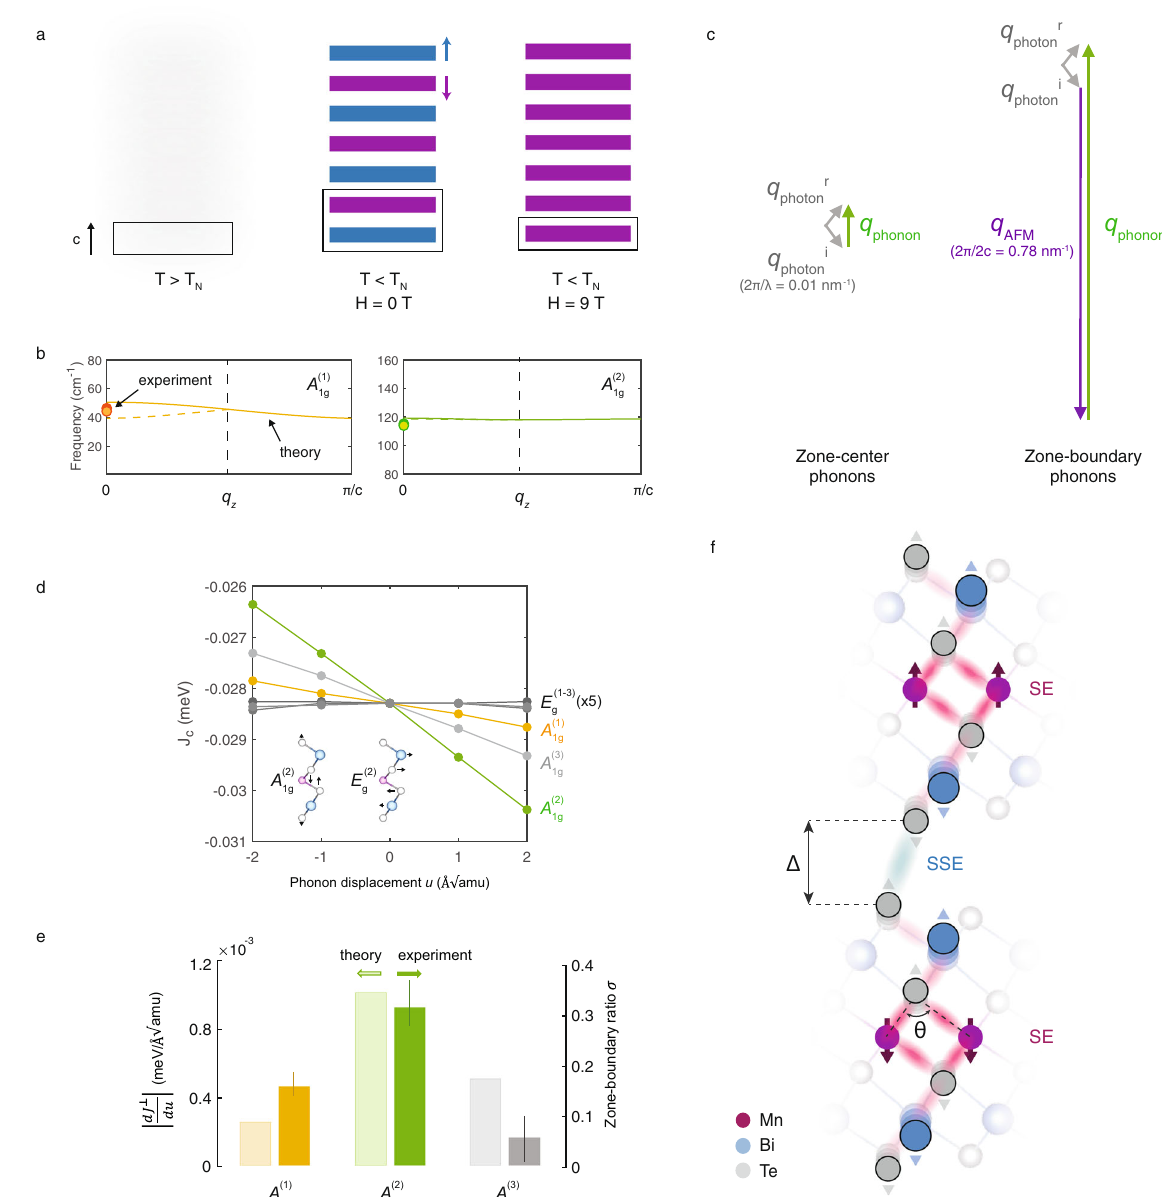
Fig. 3 Magnetophononic wave-mixing. a Schematic of layered magnetic ordering in MnBi 2 Te 4 , with blue and purple denoting opposite in-plane spin orientations, and gray denoting disordered spins. The antiferromagnetic (AFM) wavevector is shown schematically, labeled “ q AFM ” . b The dispersion relations of the A 1 g (1) and A 1 g (2) modes along the c-axis, calculated using density functional theory. The experimental zone-center and zone-boundary phonon frequencies are denoted using colored and empty circles respectively. c Schematic of wave-mixing for zone-center and zone-boundary modes. The wavevectors of the photon (i = incident, r = re fl ected), phonon, and AFM spin-wave are shown using gray, green, and purple arrows (not drawn to scale). (cid:6) (cid:6) d Modulation of the interlayer exchange coupling J ? by Raman phonons. Inset shows the eigendisplacements of two representative phonons. e Comparison (cid:6) (cid:6) (cid:6) (cid:6) and the experimental zone-boundary ratio σ (see text for de fi nition). Error bars are between the calculated magnetophononic scattering cross-section dJ ? du standard deviations in fi t values. f Schematic of superexchange (SE) and super-superexchange (SSE), with Δ denoting the interlayer distance, θ denoting the Mn – Te – Mn bond angle, and pink and blue clouds denoting SE and SSE pathways, re fl ectivity is sensitive to changes in carrier density and coherent Finally, we investigate magnetophononic coupling by direct phonons. These measurements are carried out at 2 K, as a func- measurement of phonons in the time domain. To do this, we carry tion of magnetic fi eld from 0 to 6.4 T, across the spin- fl op tran- out “ pump-probe ” experiments to generate and detect coherent sition. The transient re fl ectivity, shown in Fig. 4b, exhibits an optical phonons as a function of magnetic fi eld (see schematic in initial sub-picosecond dip, followed by a slow relaxation. Over- Fig. 4a). Excitation with ultrafast optical pump pulses (1.55 eV, layed on this are multiple distinct coherent oscillation compo- 50 fs) results in the generation of coherent phonon oscillations. A nents that (as described below), correspond to the A 1 g (1) and A 1 g (2) phonons. We normalize the pump-probe re fl ectivity traces second, time-delayed probe pulse (1.2 eV, 50 fs) measures pump- with respect to their maximum amplitudes, to account for fi eld- induced changes in the transient re fl ectivity ( Δ R/R ). The transient